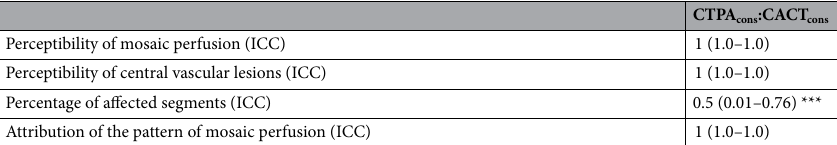
Table 3. Inter-modality agreement between CTPA cons and CACT cons. *** p < 0.001, values are given in mean with 95% confidence interval, as the ICC for any other parameter is 1, no p-Values are